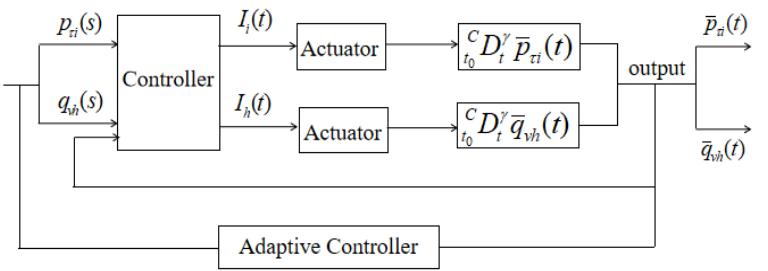
Figure 1. Control framework of adaptive feedback controller